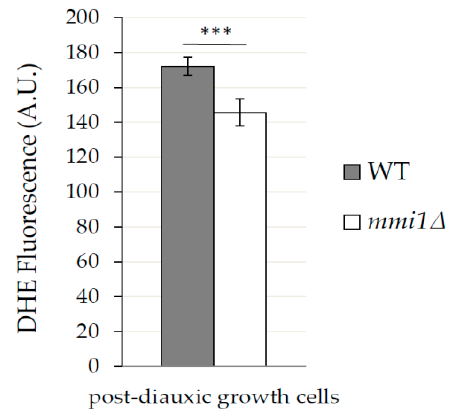
Figure 6. In post diauxic growth phase the mmi1 ∆ strain exhibits lower amount of superoxide anions compared to the WT strain. The amount of superoxide anions was determined in the WT and mmi1 ∆ strains 18 h after rapamycin treatment (200 nM). The production of superoxide anions was measured by dihydroethidium (DHE, 15 μ g/mL, 1 h, 30 °C) and samples were analyzed by the FACS flow cytometer. Results are means ± SD of two independent experiments performed in triplicates (n = 6). The statistical evaluation was performed by using two way analysis of variance (ANOVA). *** p < 0.001.